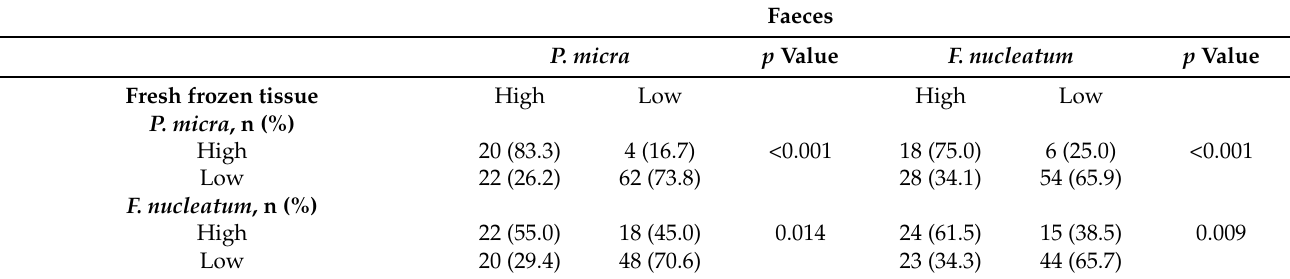
Figure 1. The levels of P. micra and F. nucleatum in CRC patients. Scatter plots illustrating the relative levels of P. micra ( Pm ) and F. nucleatum ( Fn ) in ( a ) fresh frozen tumour tissue and ( b ) faeces. Hori ‐ zontal lines indicate the cut ‐ off between high and low levels of the bacteria as calculated by the 2 −Δ Cq method using either PGT (for fresh frozen tumour tissue) or 16s RNA (for faeces) as reference. Table 1. The distribution of patients with high and low levels of P. micra and F. nucleatum in tumour tissue and in faeces.